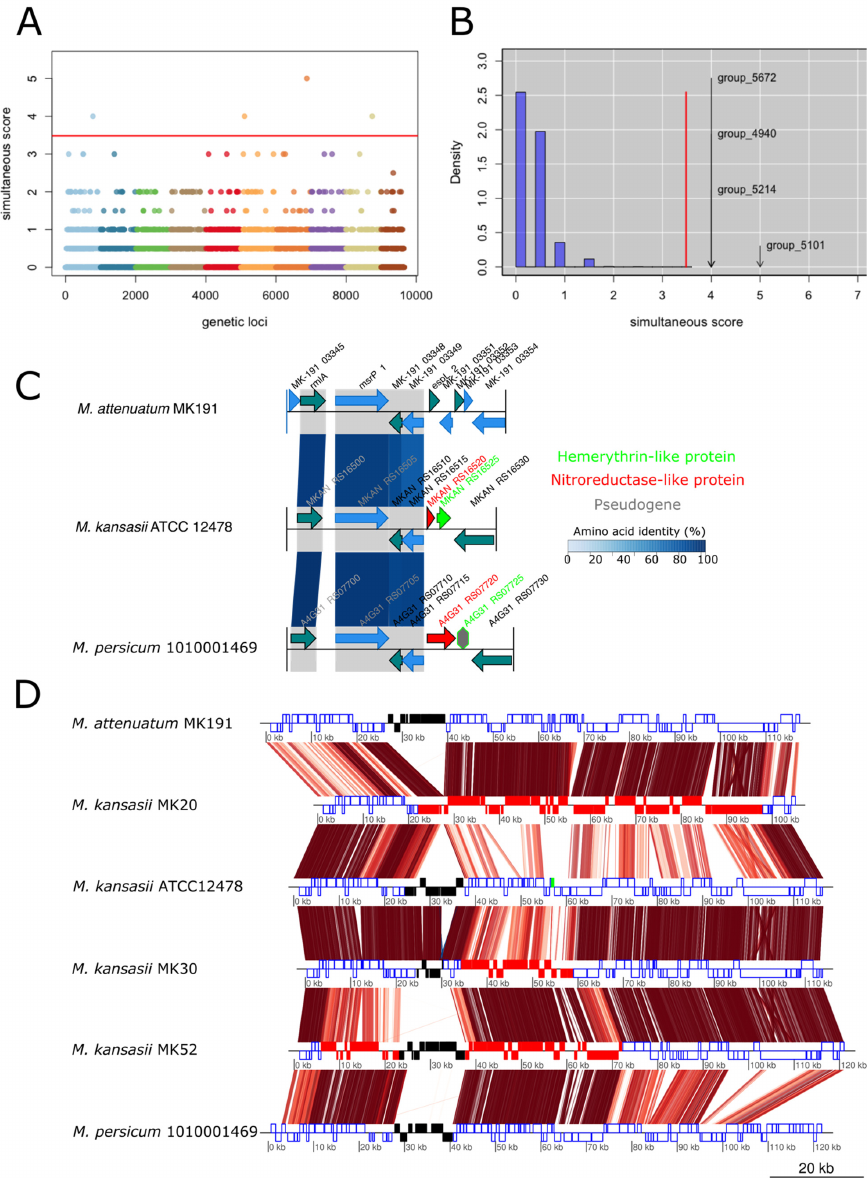
Figure 3. treeWAS results based on a matrix of presence/absence of single-copy orthologs. ( A ) Manhattan plot (colors were randomly assigned) and ( B ) bar plot of the treeWAS simultaneous score based on the presence/absence of single-copy orthologs and the core-genome phylogeny. Group_5101 and group_5214 encode for a hemerythrin-like protein and a nitroreductase-like protein, respectively, that were also identified by the terminal score. Group_5672 encodes a PE-family protein that is likely a substrate of the type-VII secretion system. Group_4940 encodes for a hypothetical protein that was negatively associated with pathogenicity. However, the gene is pseudogenized in some M. kansasii isolates and is thus most probably non-functional. ( C ) Genomic context of group_5101 and group_5214 in the representative genomes of M. kansasii , M. persicum and M. attenuatum . The hemerythrin-like protein was absent and pseudogenized in M. attenuatum and M. persicum , respectively. The nitroreductase-like protein was longer in M. persicum as compared to M. kansasii while it was absent in M. attenuatum . ( D ) The extended genomic region surrounding the hemerythrin-like protein (highlighted in green in strain ATCC 12478) present distributive conjugal transfers between M. attenuatum and M. kansasii , as well as between M. persicum and M. kansasii , leading to the loss of this protein in MK20, MK30 and MK52. Amino acid identity (from TBLASTX searches) between genomes is represented by the red stripes with a color gradient from 80% (light red) to 100% (dark red). ORFs corresponding to prophage sequences were manually highlighted based on gene annotation (not detected using